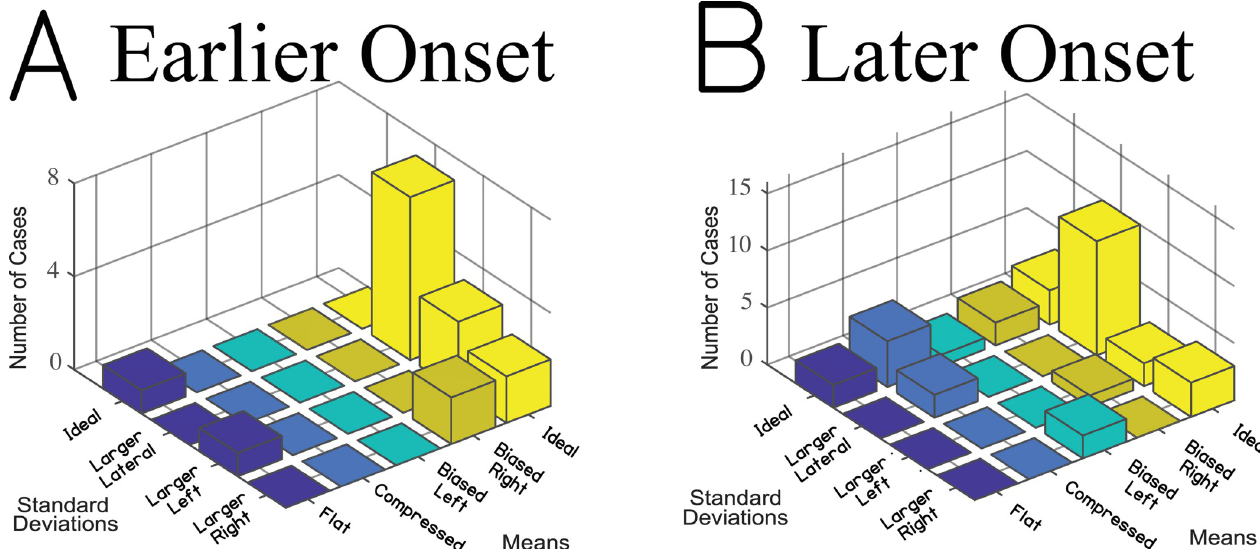
Fig 8. Histogram indicating category assignments by onset of deafness group. The x-axis corresponds to the mean category, the y-axis corresponds to the SD category, and the z-axis corresponds to the frequency of assignment (with a total of 16 listeners in panel A and 32 listeners in panel B). (A) and (B) correspond to the � 5 and > 5 years onset of deafness groups, respectively. The range of the z-axis was scaled based upon the number of listeners in each group, with the maximum equal to half of the group size.